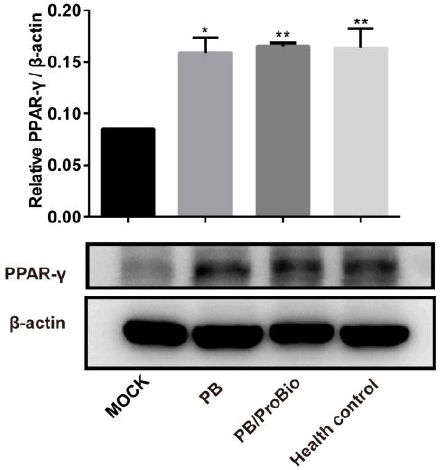
Figure 6. The expression level of PPARγ in the 4 groups. All data were presented as mean ± SEM. ( n = 3). Upper panel: Relative intensity of PPARγ protein expression calculated as the ratio of PPARγ vs. β-actin. Lower panel: Western blot analysis of PPARγ in MOCK, PB, PB/ProBio, and Health control groups. * p < 0.05, ** p < 0.01.